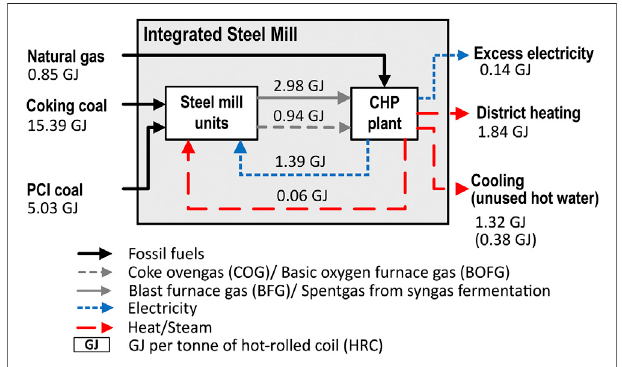
FIGURE 3 | Energy fl ows for the reference steel mill with a production of 4 Mt HRC per year; adapted from (IEAGHG, 2013; Lulekraft, 2018). The values shown are per ton of HRC.